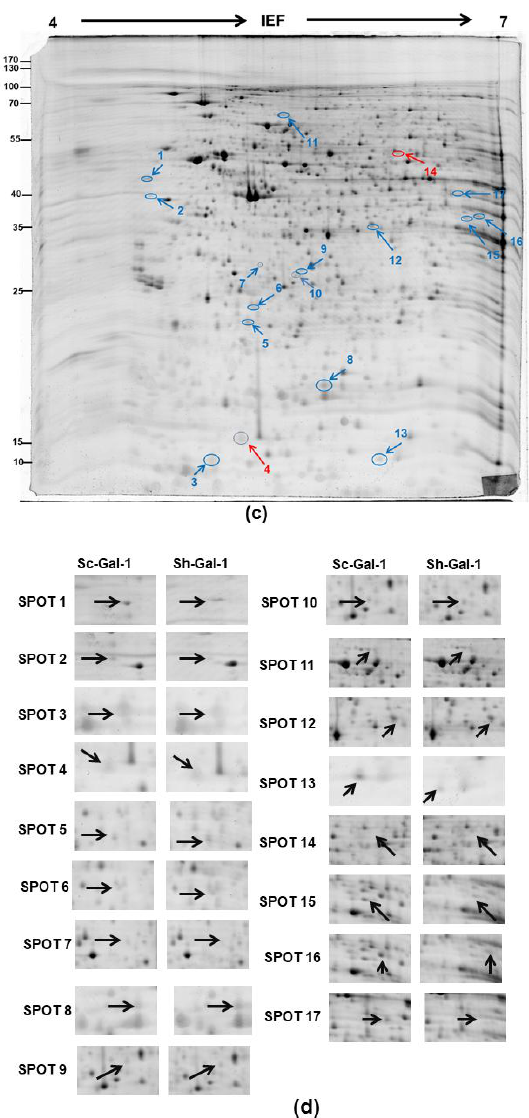
Figure 1. 2-DE protein profiles of Sc-Gal-1(+120) and Sh-Gal-1(+120) T24 cells. ( a ) The experimental design; ( b ) Sc-Gal-1 (+120) T24 cells; ( c ) Sh-Gal (+120) T24 cells. ( d ) The expanded images of de-regulated protein spots. A total of 200 μg of T24 lysate proteins was used in each 2-DE gel, carried out as described in Materials and Methods. Down-regulated protein spots were indicated by blue arrows, while up-regulated ones were indicated by red arrows.